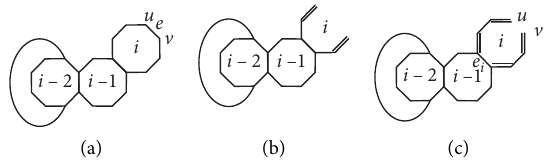
Figure 4: Illustrations of case 2 in Lemma 1. (a) G